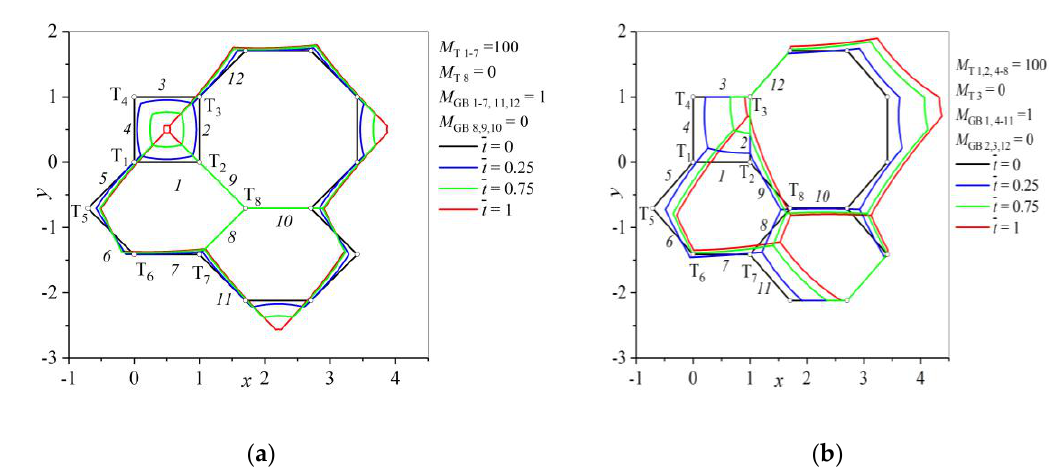
Figure 13. Evolution of the grain arrangement for different normalized times t . ( a ) Case XV: Triple point mobility M T 8 is set to zero, the mobilities of the remaining triple points are set 100. The mobilities of grain boundaries M GB 8–10 are set to zero and the remaining grain boundary mobilities M GB 1–7,11,12 are set to 1. ( b ) Case XVI: Triple point mobility M T 3 is set to value zero and remaining triple point mobilities are set to 100. Grain boundary mobilities of M GB 2,3,12 are set to zero and the remaining grain boundary mobilities M GB 1,4–11 are set to 1.